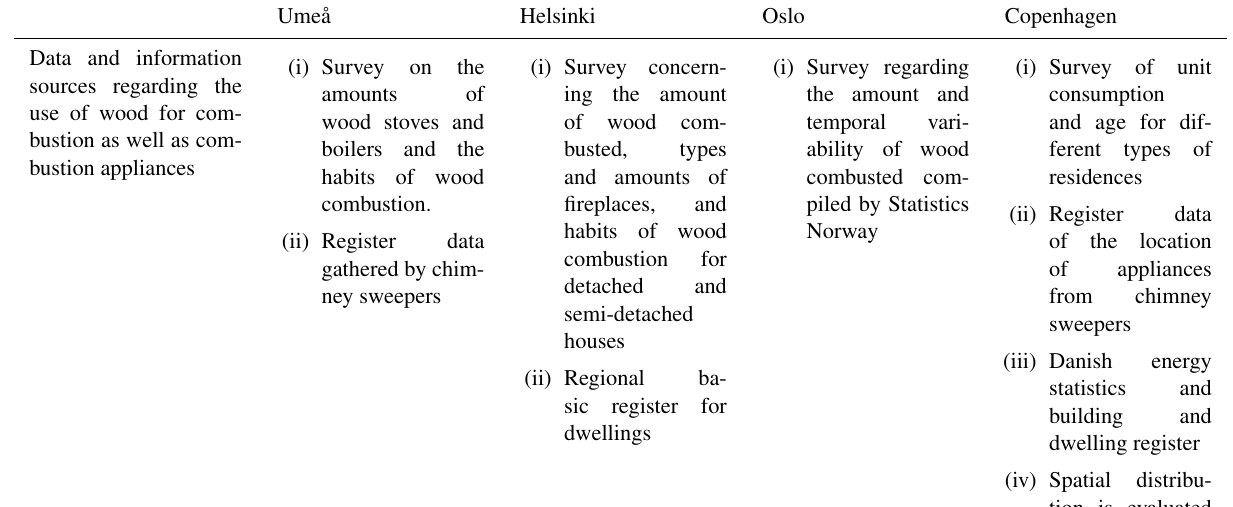
Table 1. Assessment of the emissions of PM 2 . 5 that originated from RWC and their spatial resolution in the target cities.